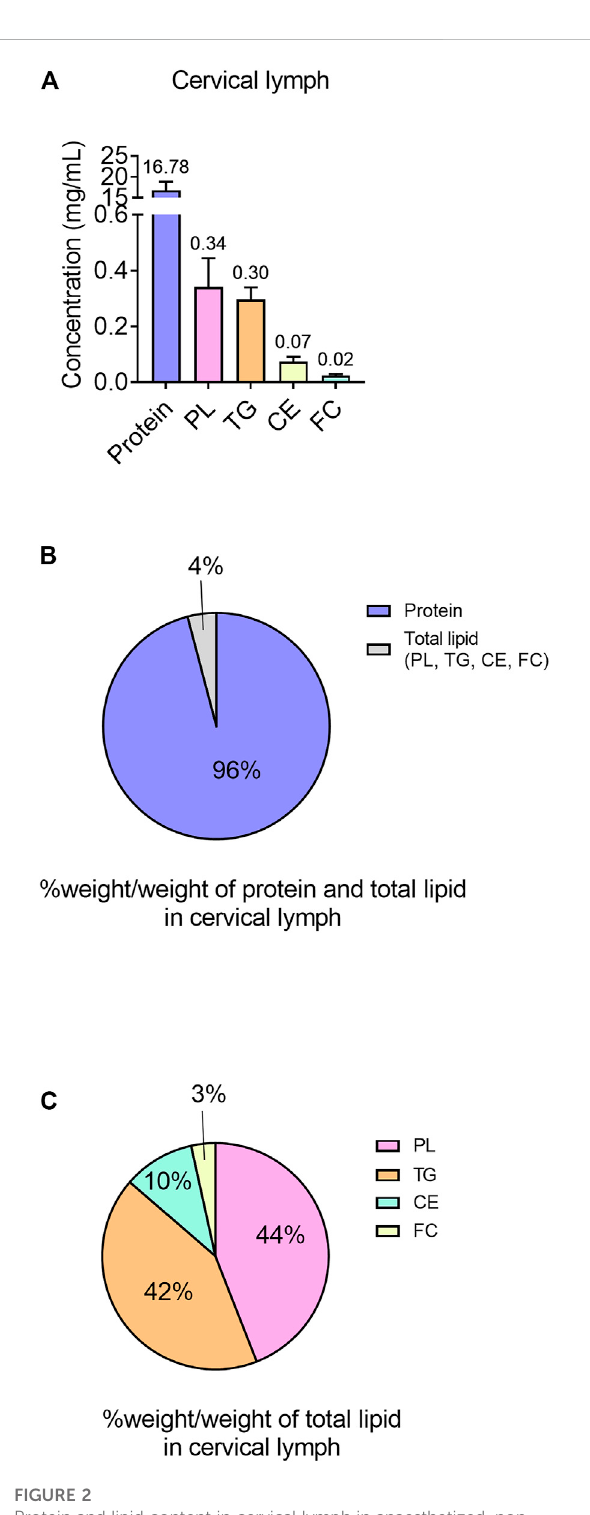
FIGURE 2 Protein and lipid content in cervical lymph in anaesthetized, non- fasted rats. (A) Concentrations (mg/mL) of protein and different lipid types (TG, PL, CE and FC) in lymph. (B) Content of protein and lipids (TG, PL, CE and FC) in cervical lymph, expressed as % weight of each component (g)/total weight of protein and total lipids (g). (C) Content of lipids(PL,TG,CEandFC)intotallipidcomponentoflymph,expressedas % weight of each component (g)/total weight of total lipids (g). Data presented as mean ± SEM (n = 3). PL = phospholipid; TG = triglyceride; CE = cholesterol ester; FC = free